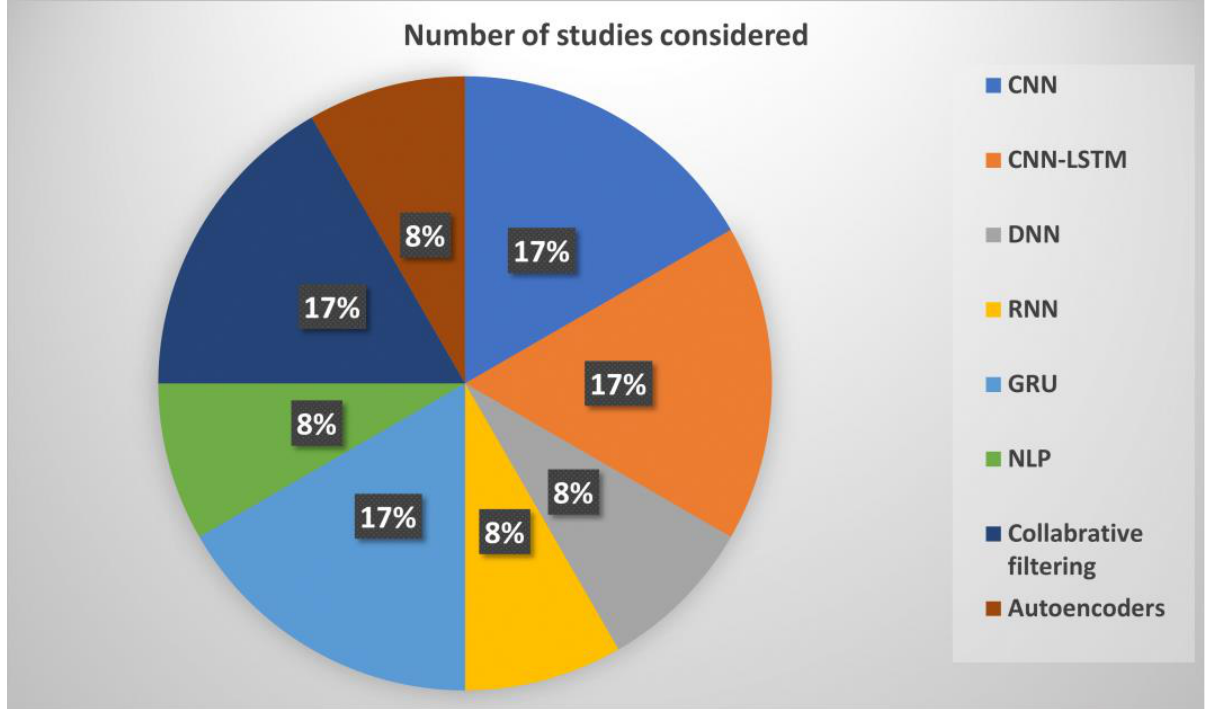
Figure 8. Approaches used to implement recommendation systems in e-commerce.